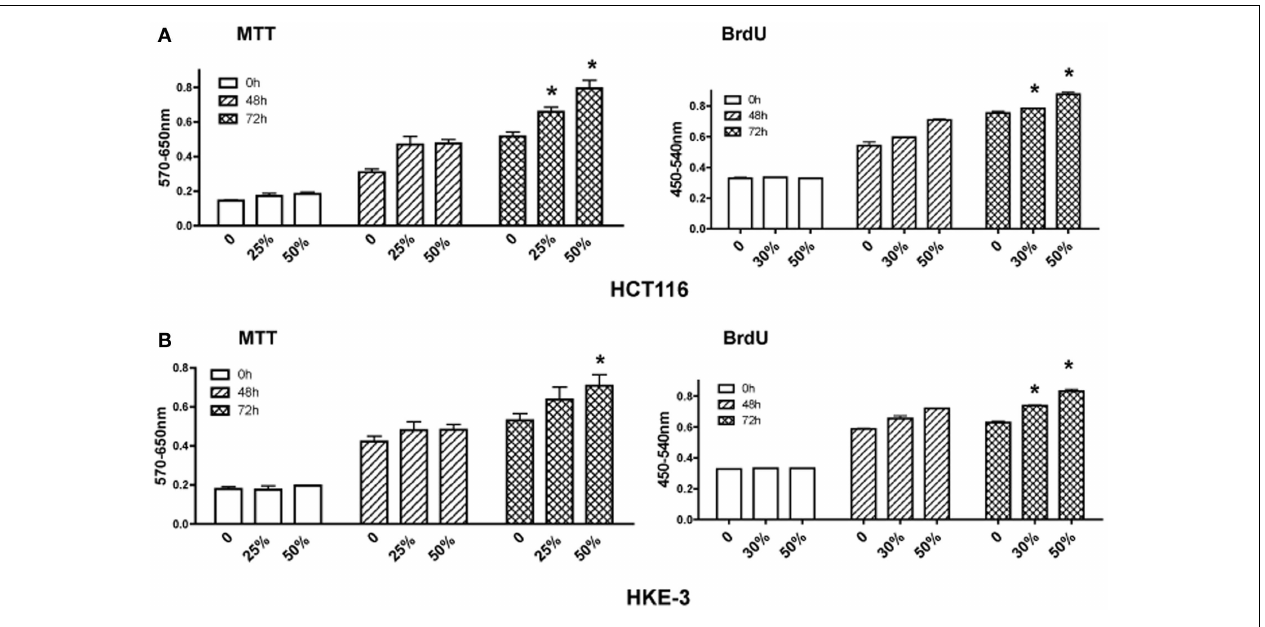
cancer-associated fibroblasts. MTT assay and BrdU incorporation were performed as described in the Section “Materials and Methods” at 48 and 72h of incubation. * p < 0.05, compared to control cells.